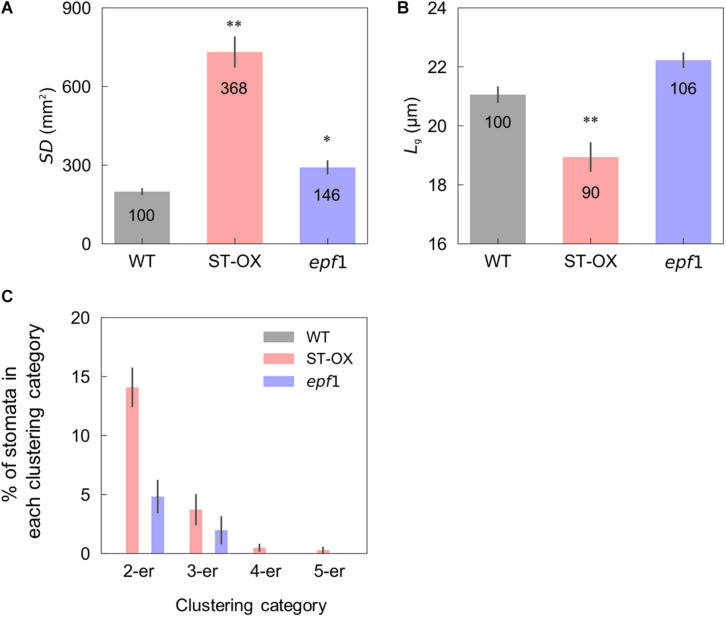
Stomatal density, size, and clustering. (A) The stomatal density (SD), (B) guard cell length (Lg) and (C) the rate of stomata in 2–5 clustering categories were evaluated on fully expanded leaves in the wild-type line (WT), a STOMAGEN/EPFL9 overexpressing line (ST-OX), and an EPF1 knockout line (epf1) of Arabidopsis thaliana. The vertical bars indicate the standard error (n = 6). * and ** indicate the significant variation in each parameter between WT and each transgenic line at p < 0.05, and 0.01, respectively, according to the Steel test in (A) or Dunnett’s test in (B). The value in each column represents the relative value of each line to WT.